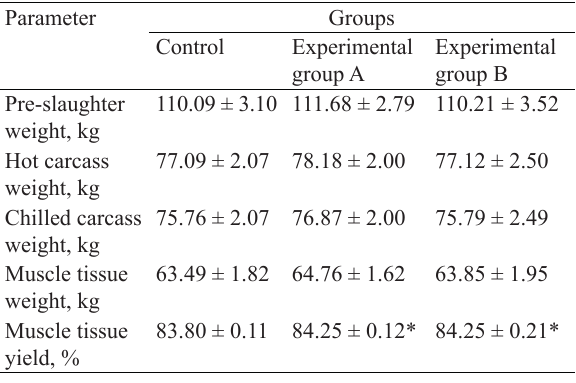
Table 5 Slaughter parameters and muscle yield of test